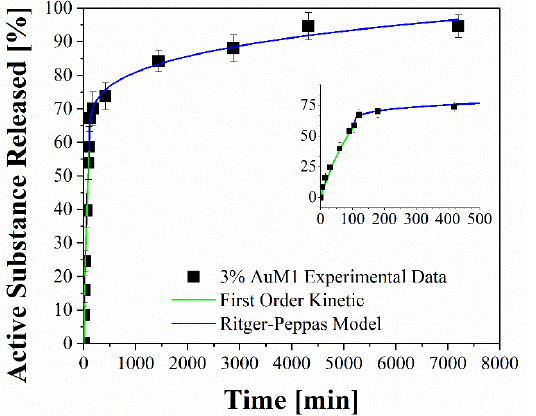
Figure 13. ( a – d ) Drug Release Curve and Modified Weibull Model for 1%AuL20 ( a ); 1%AuM1 ( b ); 3%AuL20 ( c ); and 3%AuM1 ( d ) functionalized membranes.